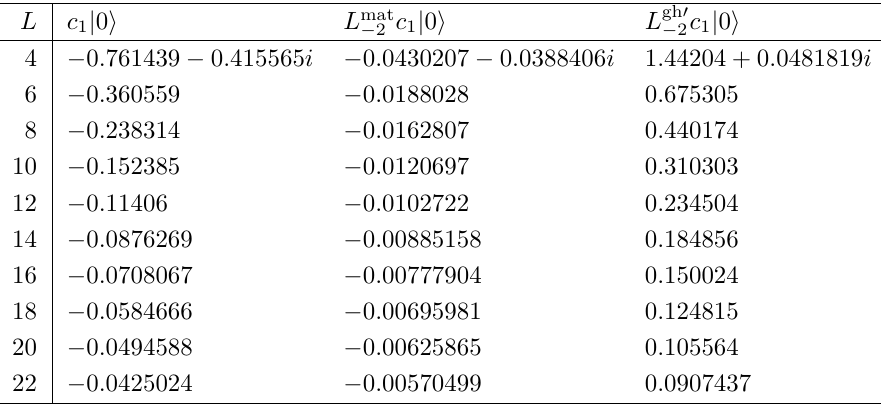
Table 4 . Coefficients of three lowest level states for the “ghost brane” solution Φ G truncation level L